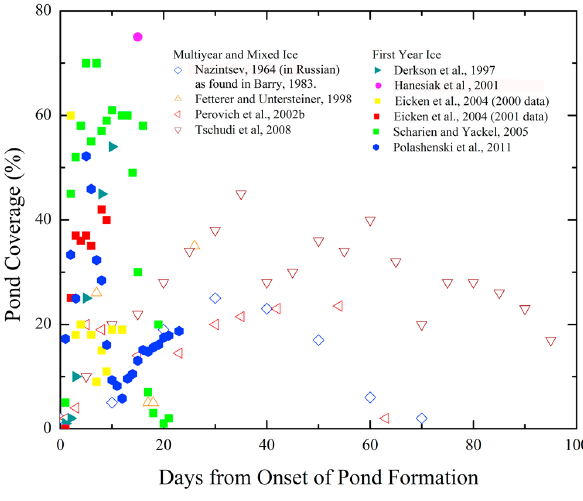
Figure 1. Pond coverage taken from various field campaigns (see legend) vs. days from onset of ponding on first-year ice (filled dots) and multiyear ice (empty dots). Melt onset proceeds rapidly to the MPF maximum on FYI with following pond drainage and moderate MPFs afterwards; on multiyear ice, the evolution of melt up to the melt maximum takes longer, the peak MPF value is lower and the MPF decrease is slower than that on FYI. Figure courtesy C. Po-